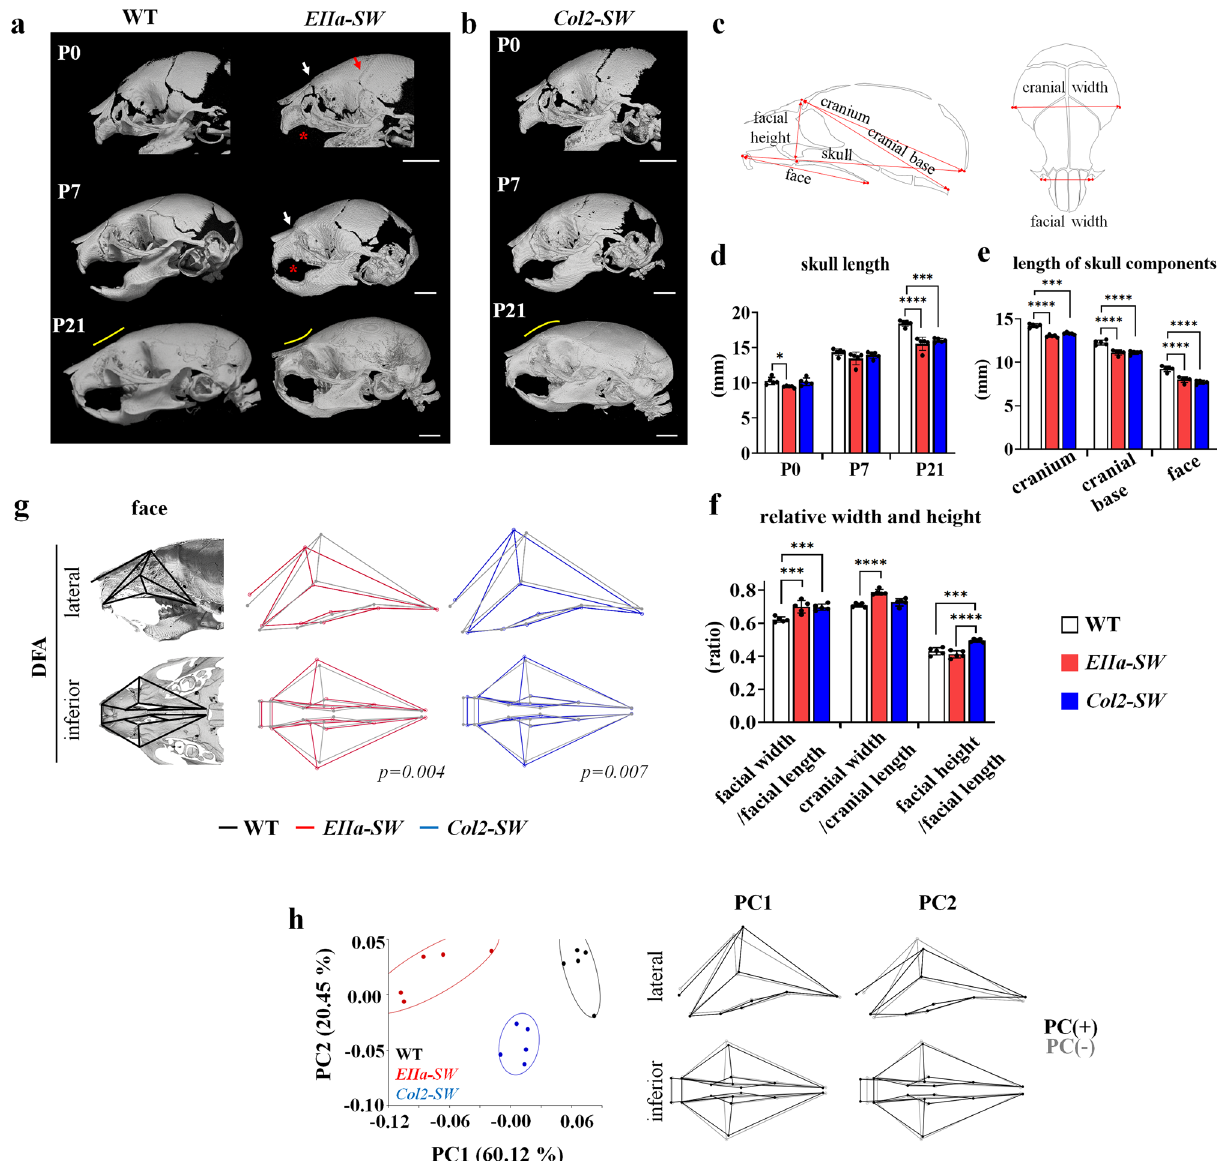
Figure 1. Chondrocyte-specific Fgfr2 S252W mutation shows progressive midface hypoplasia in the absence of premature craniofacial suture closure. ( a ) Micro-computed tomographic (CT) images of the skulls of the mouse model of Apert syndrome on postnatal days 0, 7, and 21 (P0, P7, and P21). The white and red arrows in the images of EIIa-SW mice indicate the fusion of nasofrontal and coronal sutures, respectively. The red asterisk indicates the fusion of the premaxillo–maxillary suture at P0 and P7. The yellow line indicates the curvature of the nasion. Abbreviations: pm, premaxilla; m, maxilla. Scale bar: 2 mm. ( b ) Micro-CT images of the skulls of Col2-SW mice at P0, P7, and P21. The yellow line indicates the curvature of the nasion. Scale bar: 2 mm. ( c ) Schematic of linear measurements of the craniofacial bones. ( d ) Skull lengths in each group at P0, P7, and P21. (n = 5, each stage) ( e ) Linear measurements of the cranium, the cranial base, and the face at P21 (n = 5). ( f ) The facial width and the height, and the cranial width in relation to their length at P21 (n = 5). ( g ) The facial shapes of the two groups were compared in discriminant function analysis (DFA). The first column indicates the analyzed facial region in the lateral and inferior views. The mean facial shape is displayed by wireframe images. The p values for permutation tests (1000 permutations) between the two groups are listed below of the wireframe images. (n = 5) ( h ) The variance in the facial shape was analyzed by principal components analysis (PCA). The percentage of total variance for each principal component is displayed on the axis. The shape changes are represented with wireframe images by the axis along the negative principal component axis (gray line) or positive principal component axis (black line) (n = 5). Values are presented as means ± standard deviations. * p ≤ 0.0332, ** p ≤ 0.0021, *** p ≤ 0.0002, **** p ≤